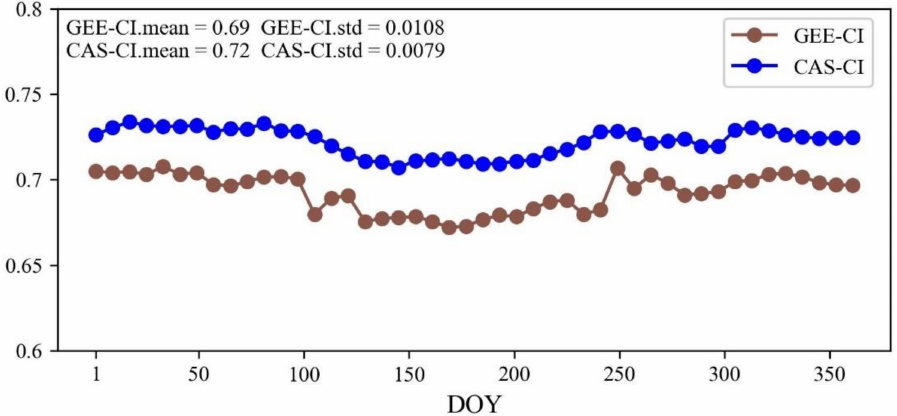
Figure A1. Comparisons of the CI time series derived from GEE and the CAS-CI (8-day,